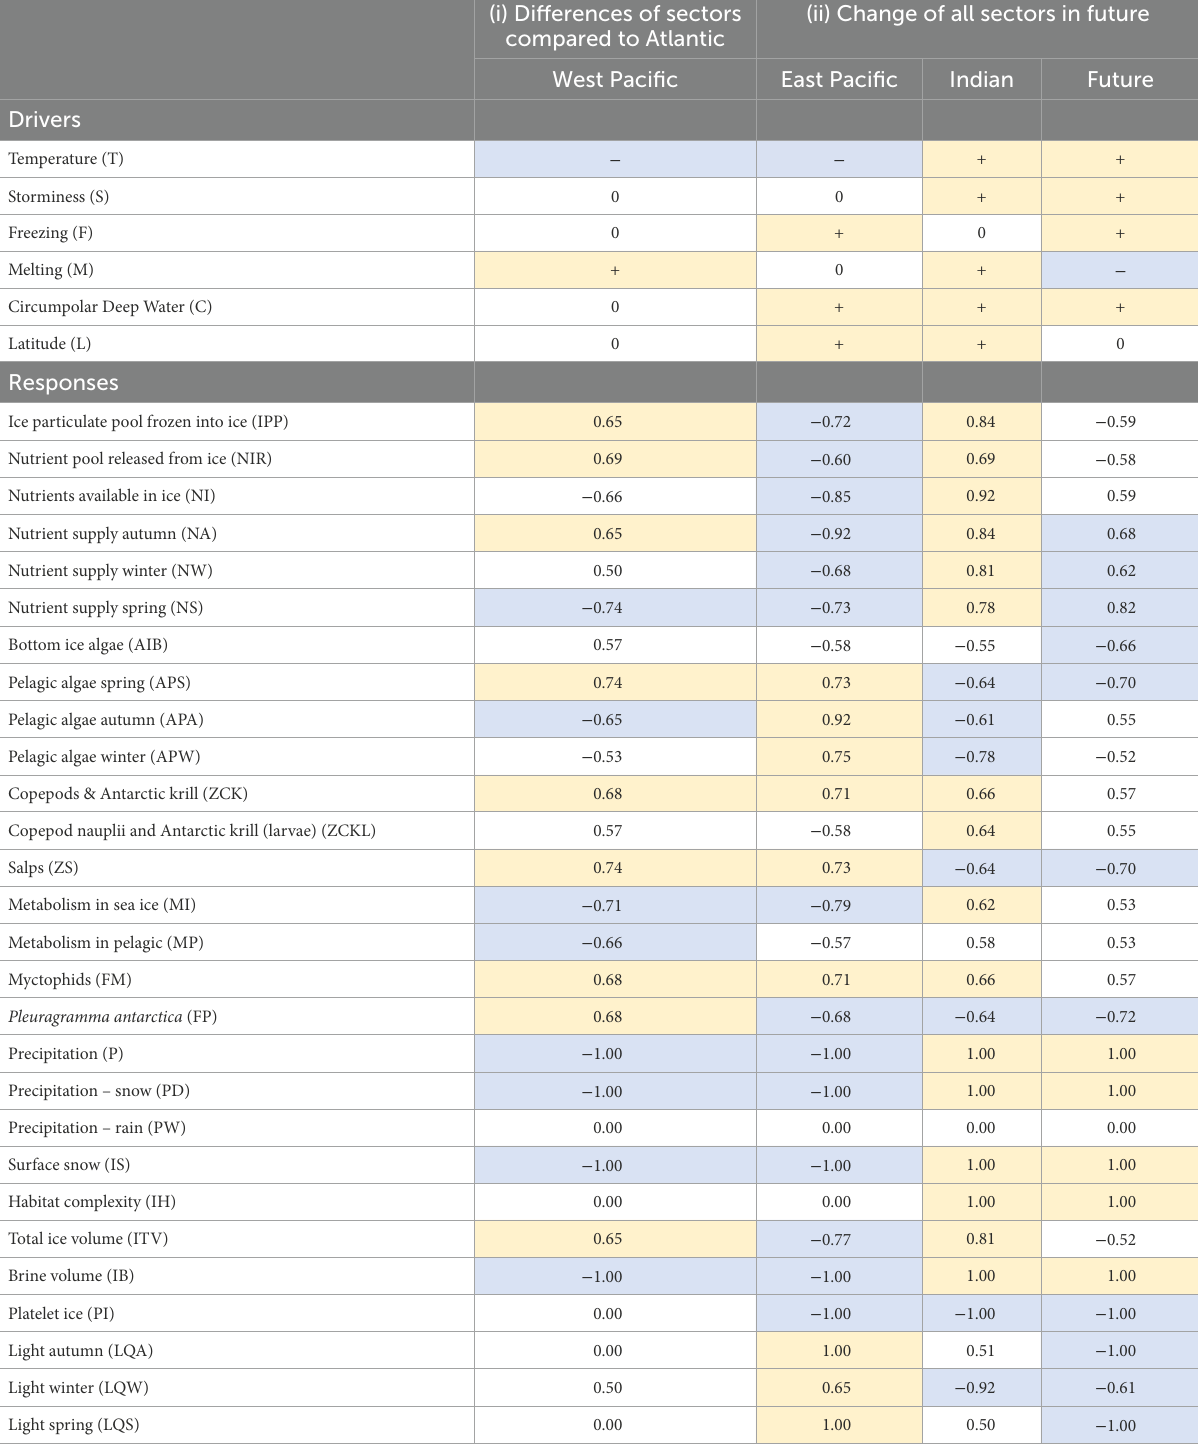
TABLE 4 Responses of attributes of the sea ice system from qualitative press perturbations of (i) differences in key drivers between MEASO sectors (see Figure 2) relative to the Atlantic Sector, and (ii) changes in the key drivers in all sectors into the future. (i) Differences of sectors (ii) Change of all sectors in compared to Atlantic